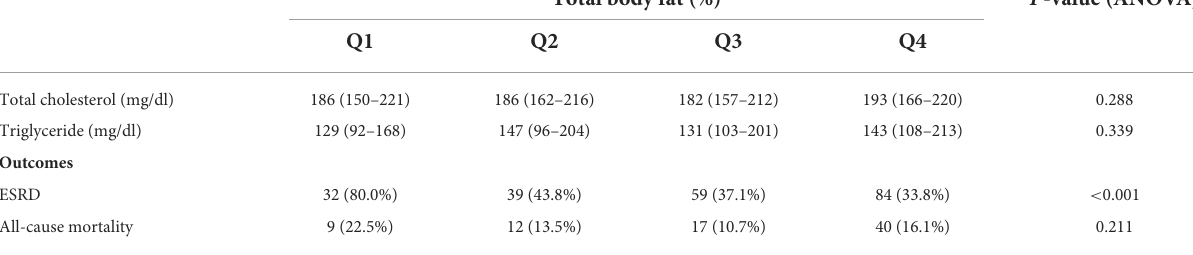
TABLE 3 Linear regression for total body fat percentage by BMI < 25 kg/m 2 and BMI ≥ 25 kg/m 2 (per 10% increase).